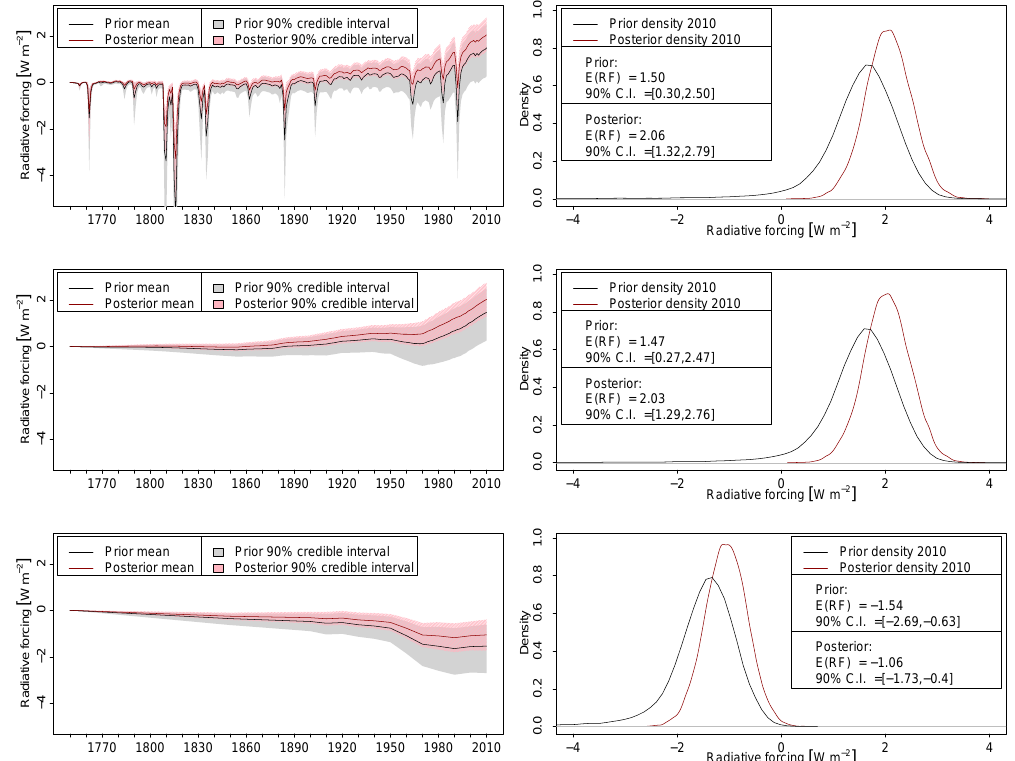
Fig. 1. Prior and posterior distribution of the RF time series and PDF of RF in 2010 for total RF (upper panel), anthropogenic RF (middle panel) and total aerosol effect (direct effect, cloud albedo effect, cloud lifetime effect and semi-direct effect) (lower panel) from the main analysis. Red colour for the posterior distributions and black lines and grey shadings for the prior